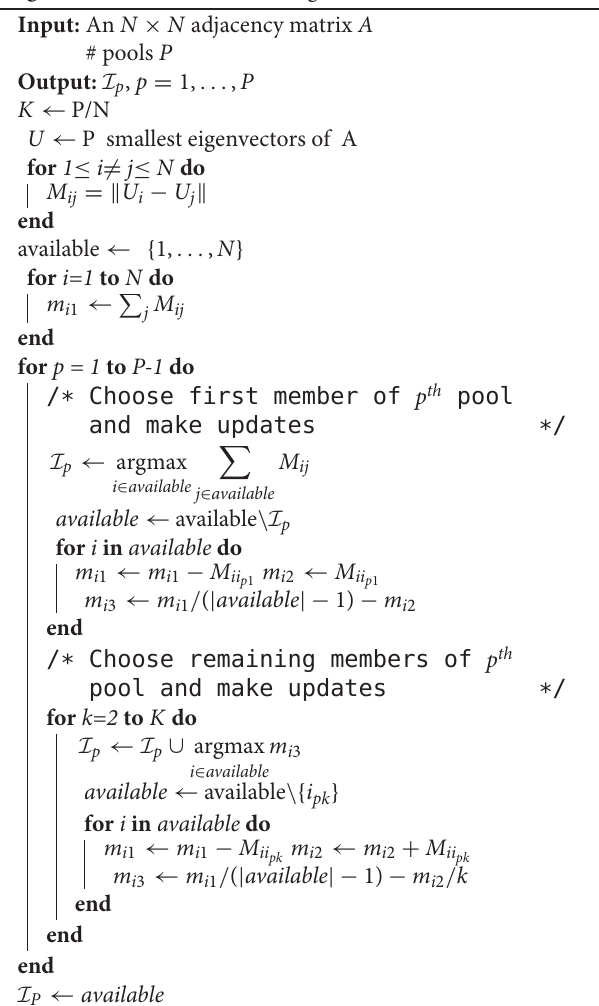
Algorithm 1: Divisive Pool Assignment